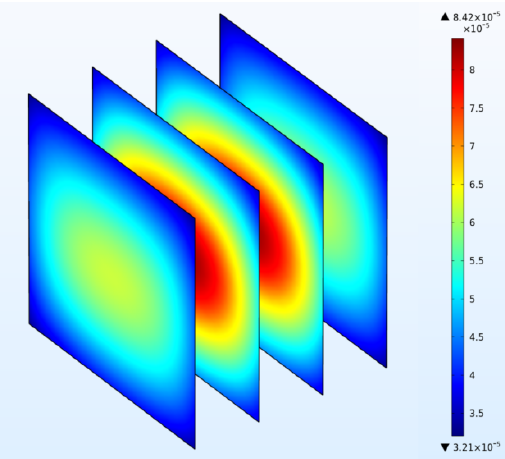
Figure 10. Distribution of vapor concentration (mg · cm − 3 ) in potato samples during RF drying from simulation ( t = 12 h).